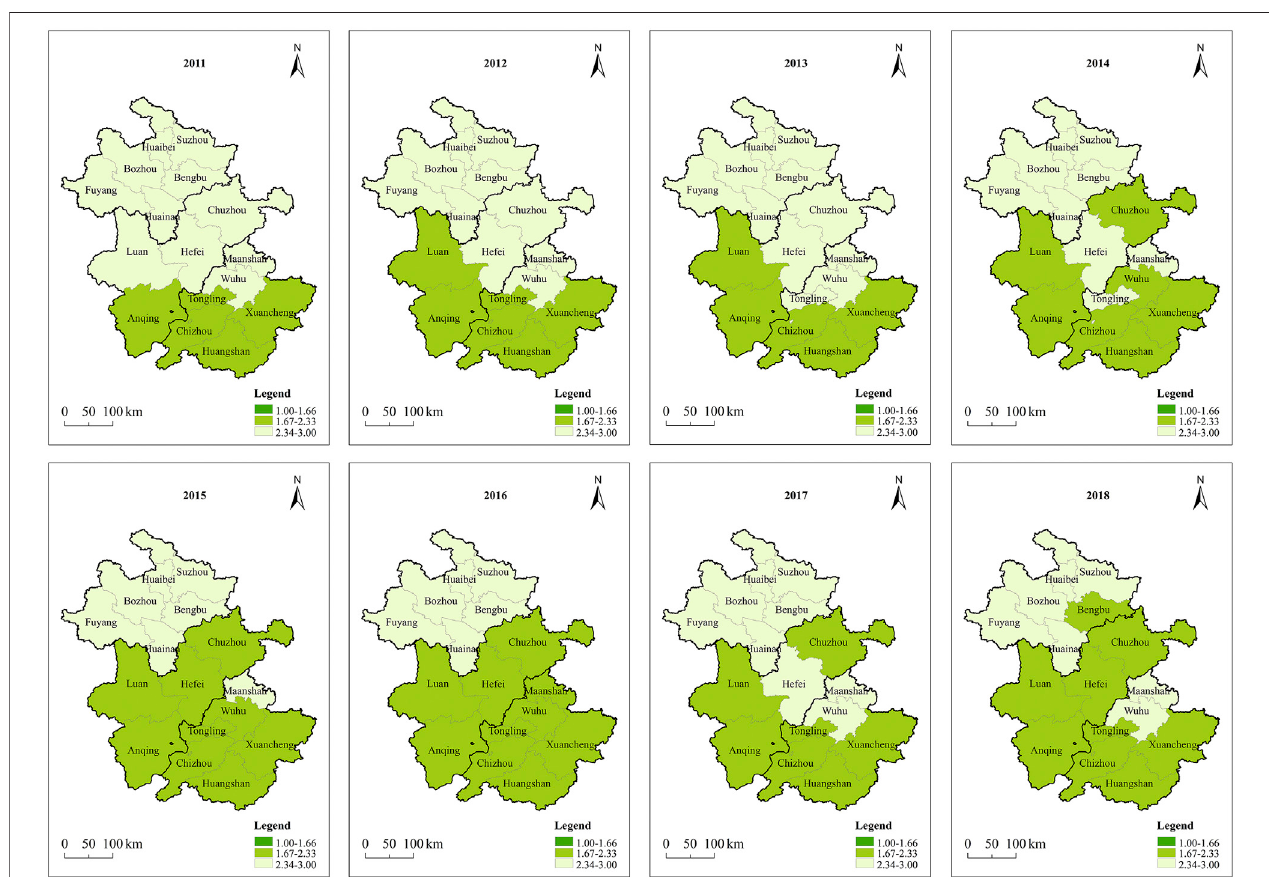
FIGURE 8 | Temporal and spatial changes of the water resources carrying capacity in Anhui Province from 2011 to 2018.